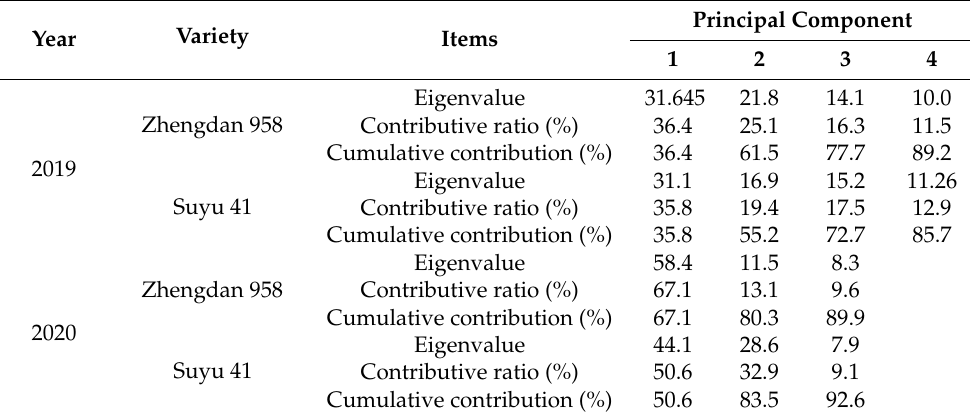
Table 4. Comprehensive index value (Cl), subordinate function value u(X), comprehensive